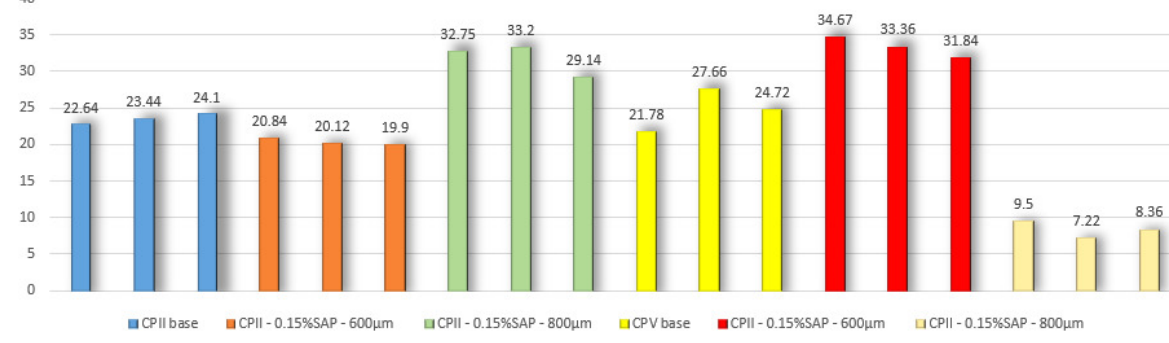
Figure 3. Compressive strength of CP’s at 28 days (MPa).